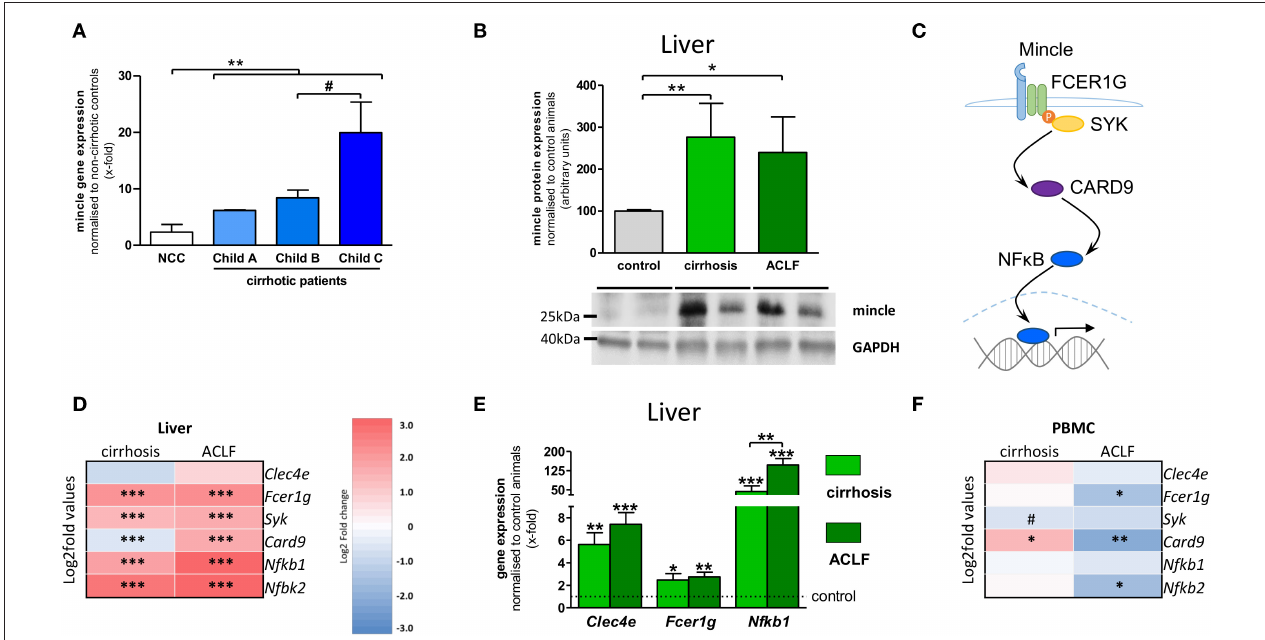
FIGURE 2 | Hepatic mincle in cirrhosis and ACLF. (A) Gene expression of mincle (gene CLEC4E ) in cirrhotic patients stratified by severity of chronic liver disease compared to non-cirrhotic controls (NCC). (B) Representative Western blot showing protein levels of mincle in control, cirrhotic induced by bile-duct ligation (BDL), and rats with acute-on-chronic liver failure (ACLF) induced by lipopolysaccharide (LPS) within cirrhosis and quantification of the Western blots. (C) Diagram of mincle downstream signaling via FC receptor gamma chain (FCER1G), spleen associated tyrosine kinase (SYK), caspase recruitment domain family member 9 (CARD9) and nuclear factor kappa B (NF κ B) leading to expression of pro-inflammatory genes. (D) Heatmap of mincle and downstream signaling maker expression in cirrhotic and ACLF livers. (E) Gene expression analysis of Clec4e , Fcer1g , and Nfkb1 by qPCR in cirrhotic and ACLF liver compared to sham-operated control. (F) Heatmap of mincle and downstream signaling maker expression in cirrhotic and ACLF peripheral blood mononuclear cells (PBMC). Arrows indicate the respective band used for quantification in cases when more than one band is shown in the representative Western blots. In heatmaps, statistical comparison was performed between cirrhosis or ACLF and sham-operated control rats. Upregulation is marked by red colors and downregulation by blue colors. * p < 0.05; ** p < 0.01; *** p < 0.001; # p < 0.1 using non-parametric Mann–Whitney U t -test or FDR-adjusted paired t -test for data from microarray assay.